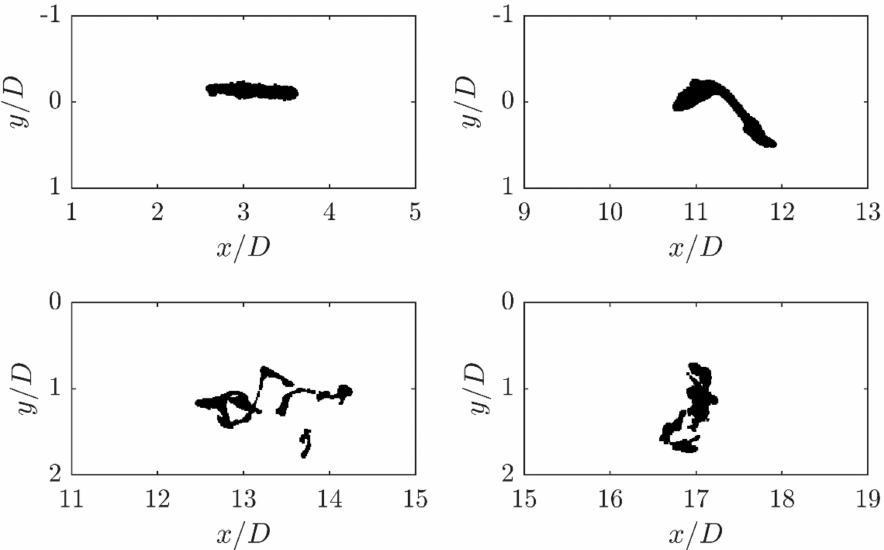
Figure 17. Visualization of droplet deformation for four single droplets in different areas of the free jet behind the orifice.